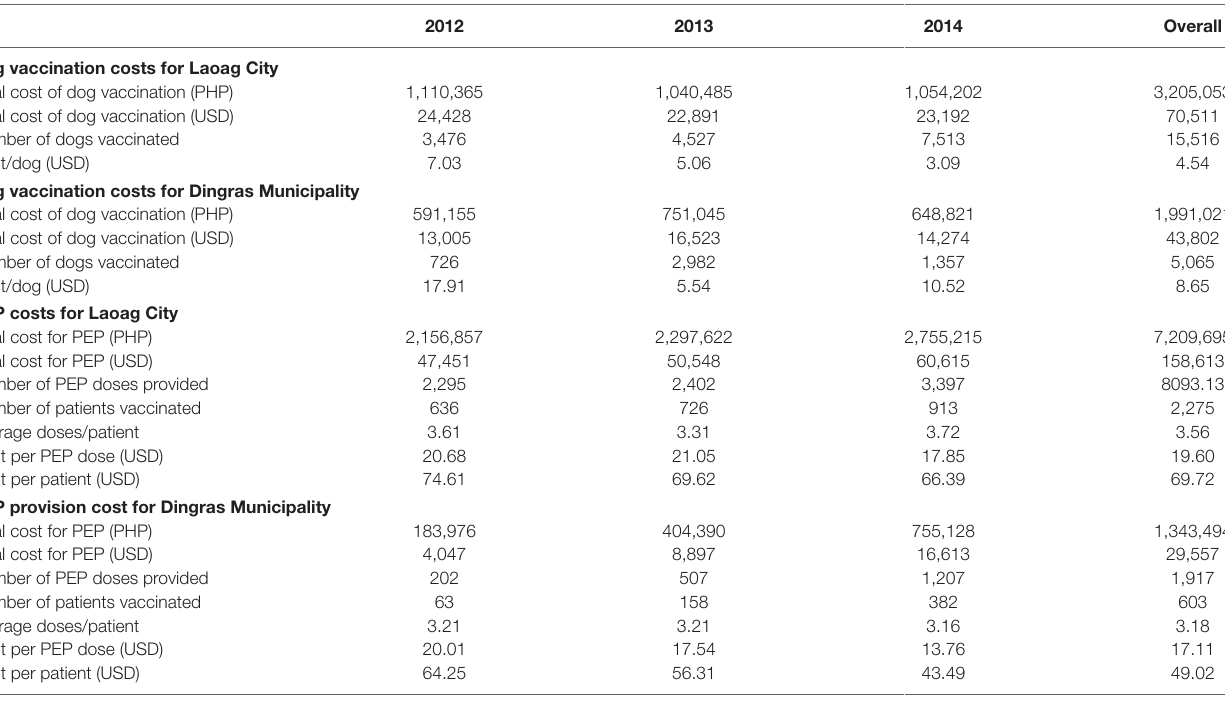
TaBle 3 | Programmatic costs for dog vaccination and postexposure prophylaxis (PeP) provision in laoag city and Dingras Municipality.